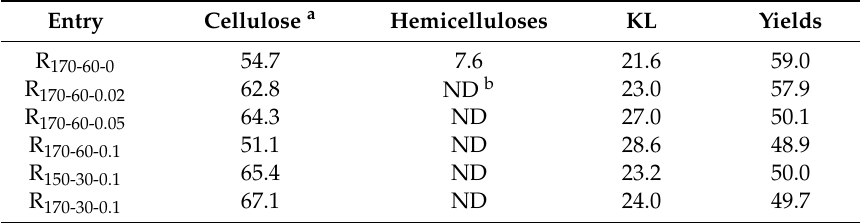
Table 1. Yields (%, w / w) and chemical compositions (%, w / w) of the resulting solid residue obtained by di ff erent 2-Methyltetrahydrofuran / aqueous (MTHF / H 2 O) systems. Entry Cellulose a Hemicelluloses KL Yields R 170-60-0 54.7 7.6 21.6 59.0 R 170-60-0.02 62.8 ND b 23.0